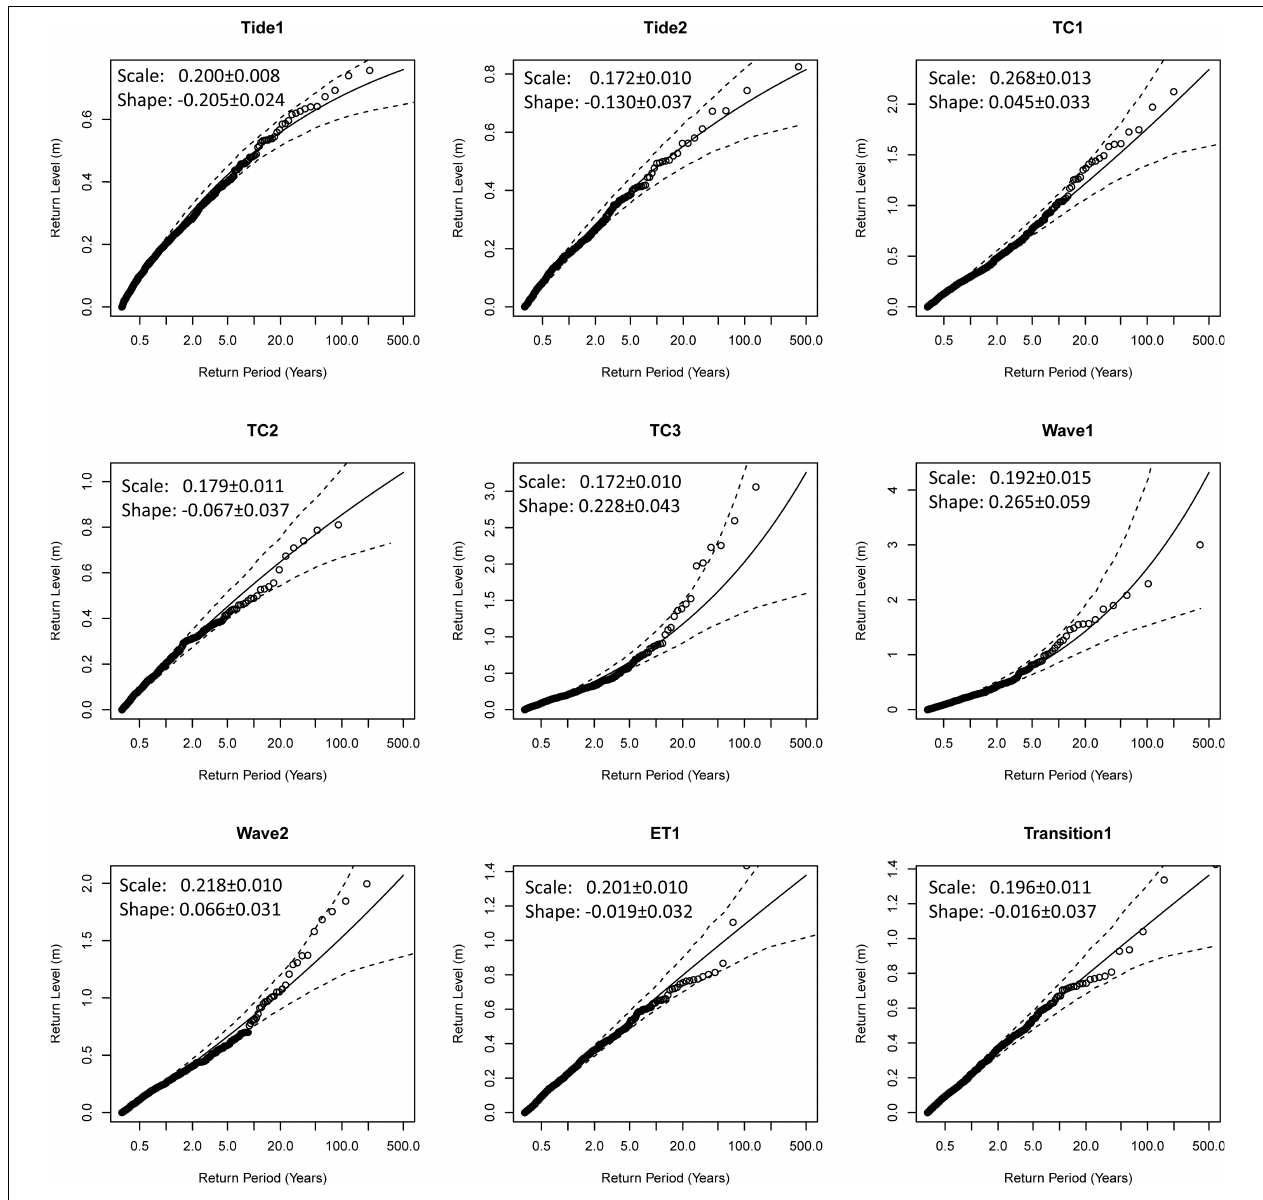
FIGURE 3 | Normalized TG data and the regional extreme sea level (RESL) return level curves with 90% confidence intervals (5th and 95th% levels) as mapped in Figure 2 . The y-axes are in meters above